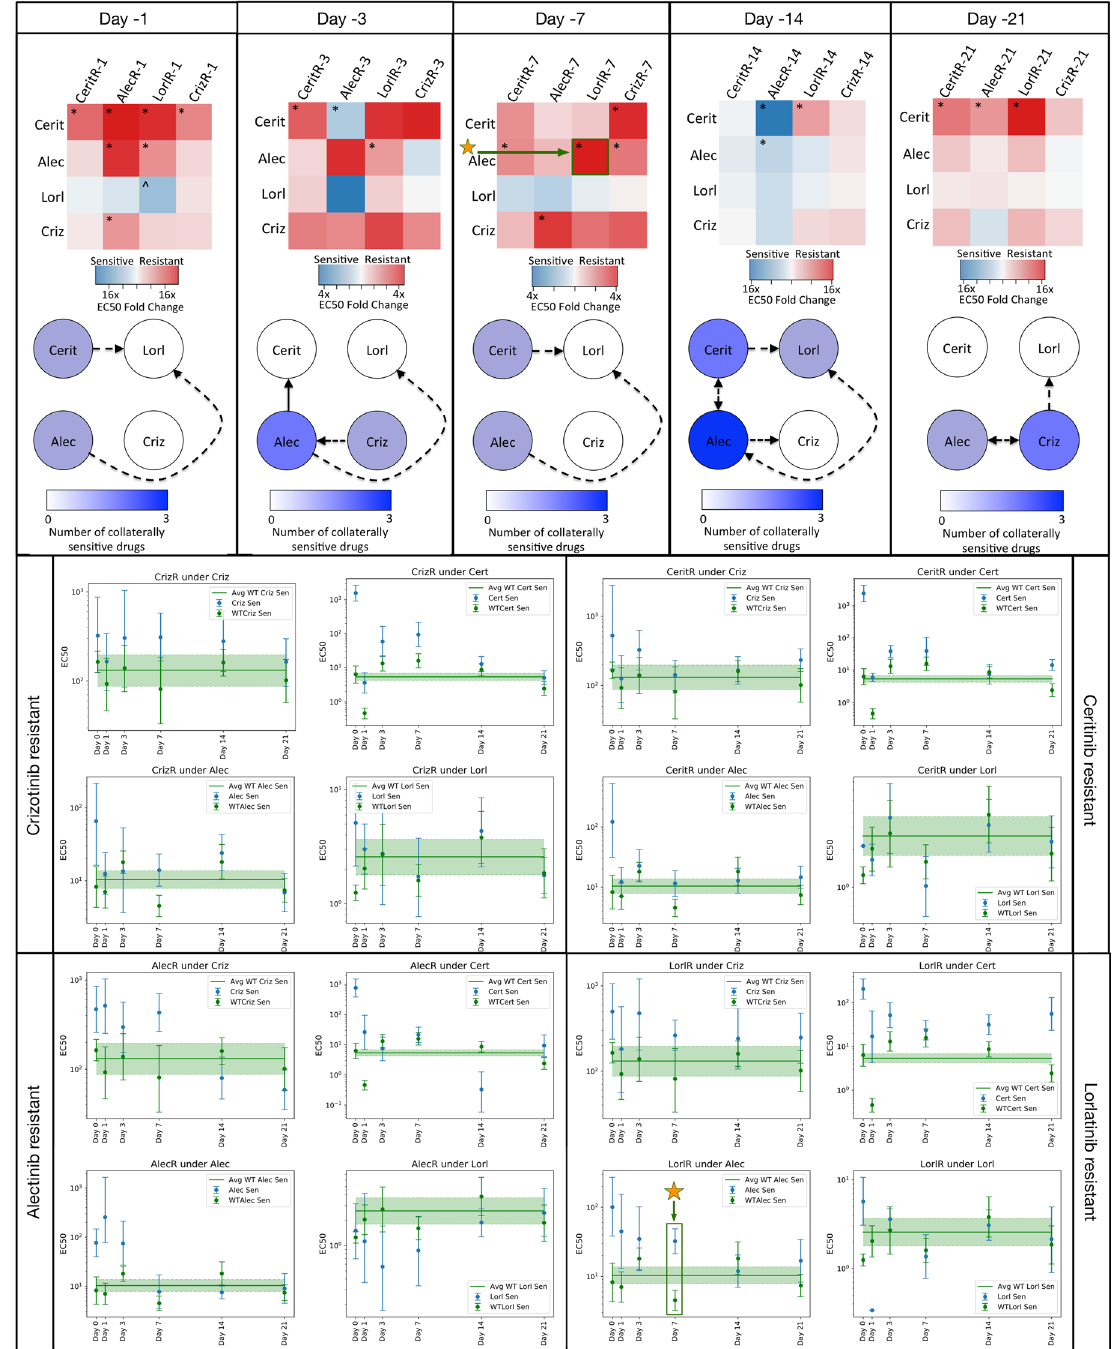
Figure 2. Upper panels: Collateral sensitivity heatmaps depicting fold change of EC50 for resistant cell lines, during the therapy holiday lasting for 1 day, 3 days, 7 days, 14 days, and 21 days, as treated with the panel of ALK TKIs (rows). The asterisk ( * ) refers to a significant change in EC50 from treatment-naive, with non-overlapping 95% confidence intervals. Non-significant changes are those not demarcated by either symbol. Below these are collateral sensitivity networks depicted as directed graphs for cells during therapy holiday. Each named node represents the resistant population to that drug; an edge exists from node i to node j if cells resistant to drug i are sensitive to drug j . The colour of each node represents the number of drugs to which the cell line represented by that node is sensitive (i.e. the number of out edges). Dotted arrows indicate those in which 95% confidence intervals for treatment-naive EC50 overlapped with that of cell line tested. Lower panels: Time-series representations of EC50 data, depicting comparison between relaxing EC50 and treatment-naive EC50, during the course of experiment. The average treatment-naive EC50 (green confidence interval) is derived from the five treatment-naive measurements. Significance in the upper panel is determined by non-overlapping confidence intervals, exemplified by the marked data (orange stars), for the case of lorlR cells treated with alectinib on day 7 of